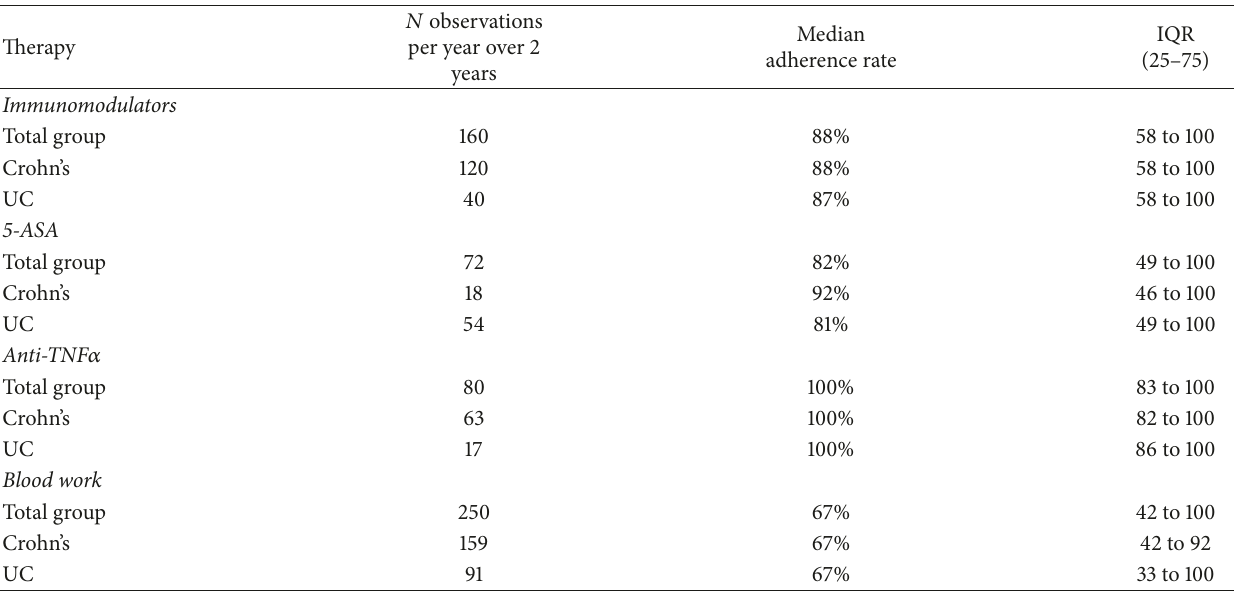
Table 2: Adherence